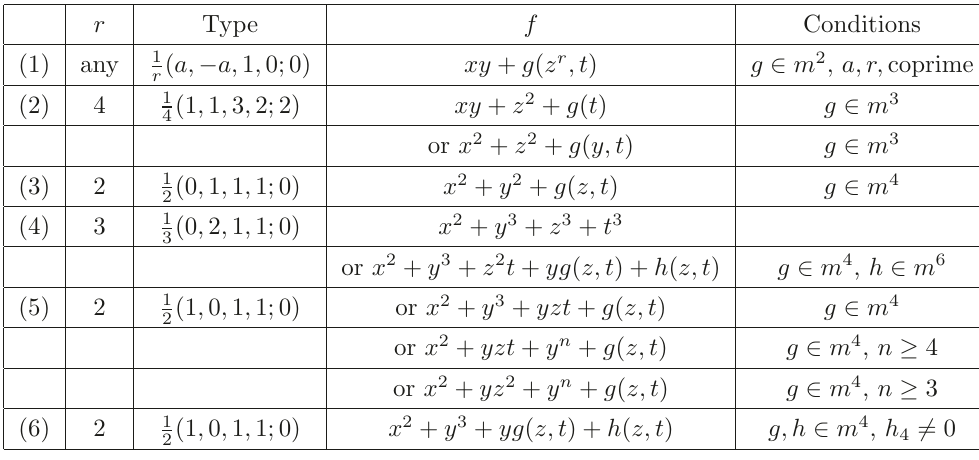
Table 1 . List of three-fold terminal